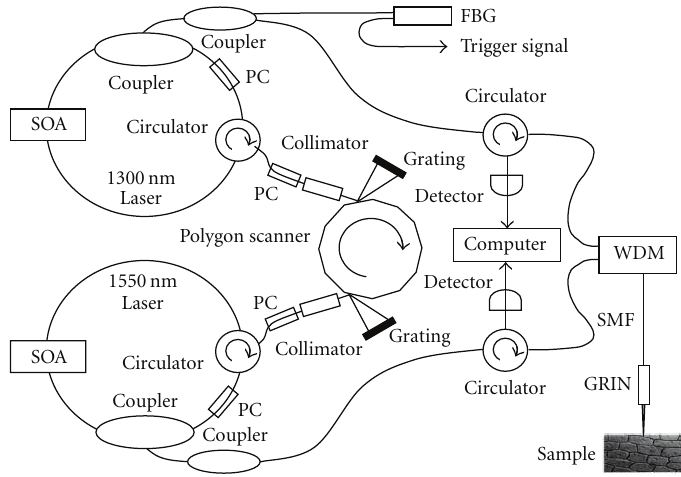
Figure 2: Schematic diagram of the dual-source swept-source OCT system. PC: polarization controllers, FBG: fiber Brag grating. SOA: semiconductor optical amplifiers; WDM: wavelength division multiplex; SMF: single-mode optical fiber.